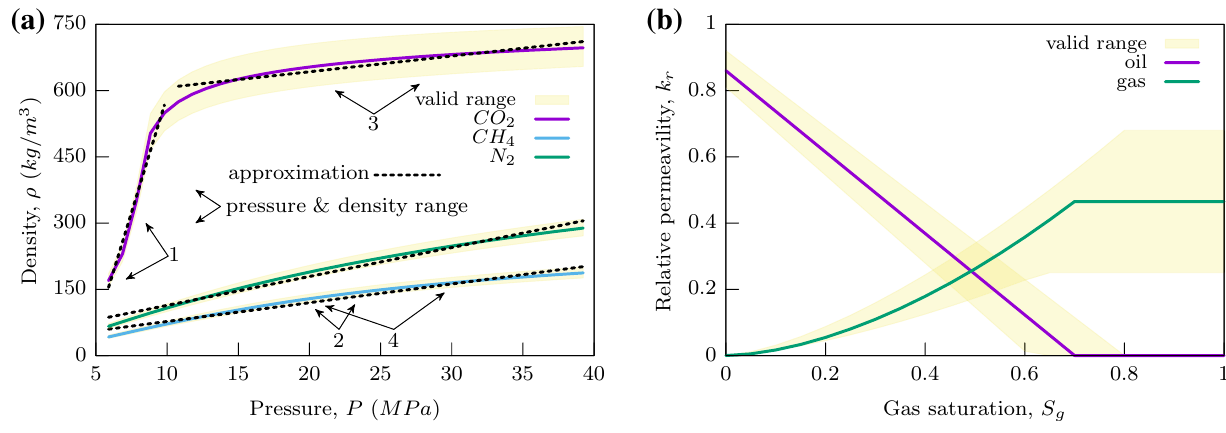
Fig. 2 a Set of density curves and their range for different injected gases. 1, 2, 3, 4—calculations depicted in the article (see Table 2). b Set of relative permeability curves and their range for oil–gas system